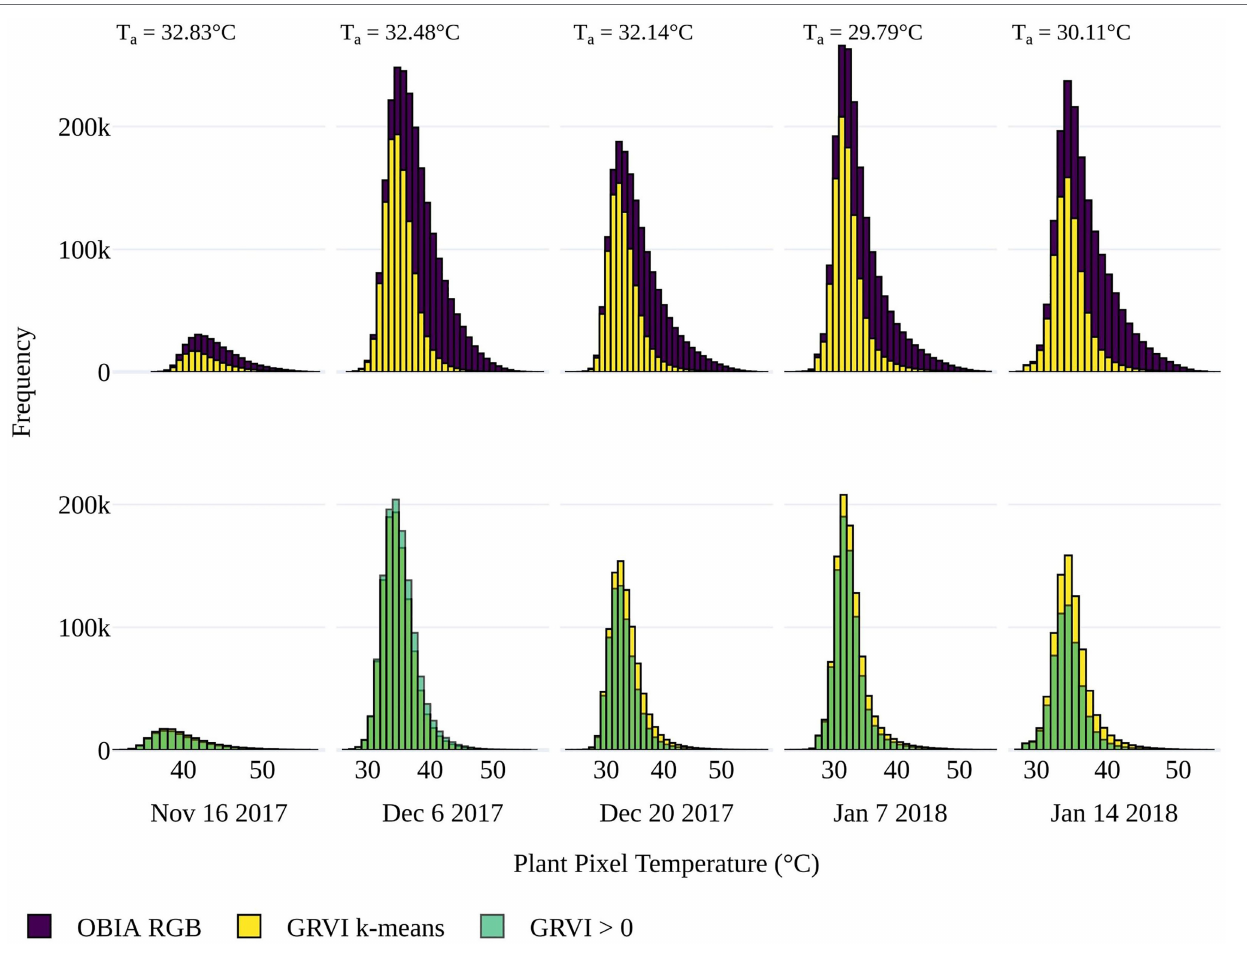
FIGURE 4 | Top Distribution of pixel-based temperatures within the plant delineations from the OBIA approach applied to the red green blue (RGB) data (purple) and for vegetation within the delineations determined by k-means clustering using a two-cluster a priori on the (GRVI; yellow) for the five UAV data collection dates. Bottom) The distribution of pixel-based temperature for vegetation classified where GRVI > 0 (green), overlaid on the k-mean approach (yellow) for comparison. When there is a greater frequency of pixels classified as vegetation with GRVI > 0 than the k-means approach (i.e., for December 6), it is shown in a lighter green color. Average air temperature (T a ) is shown for each flight.